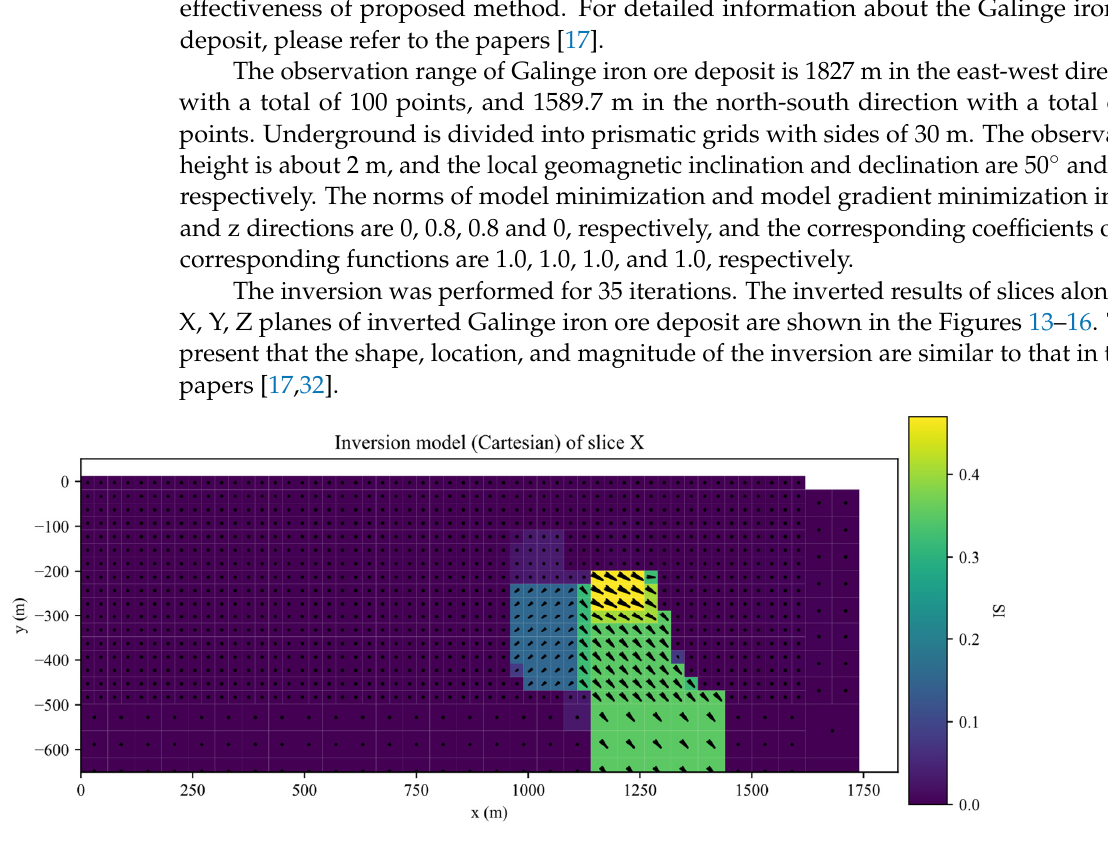
Figure 13. Slices along the X planes of inverted Galinge iron ore deposit.